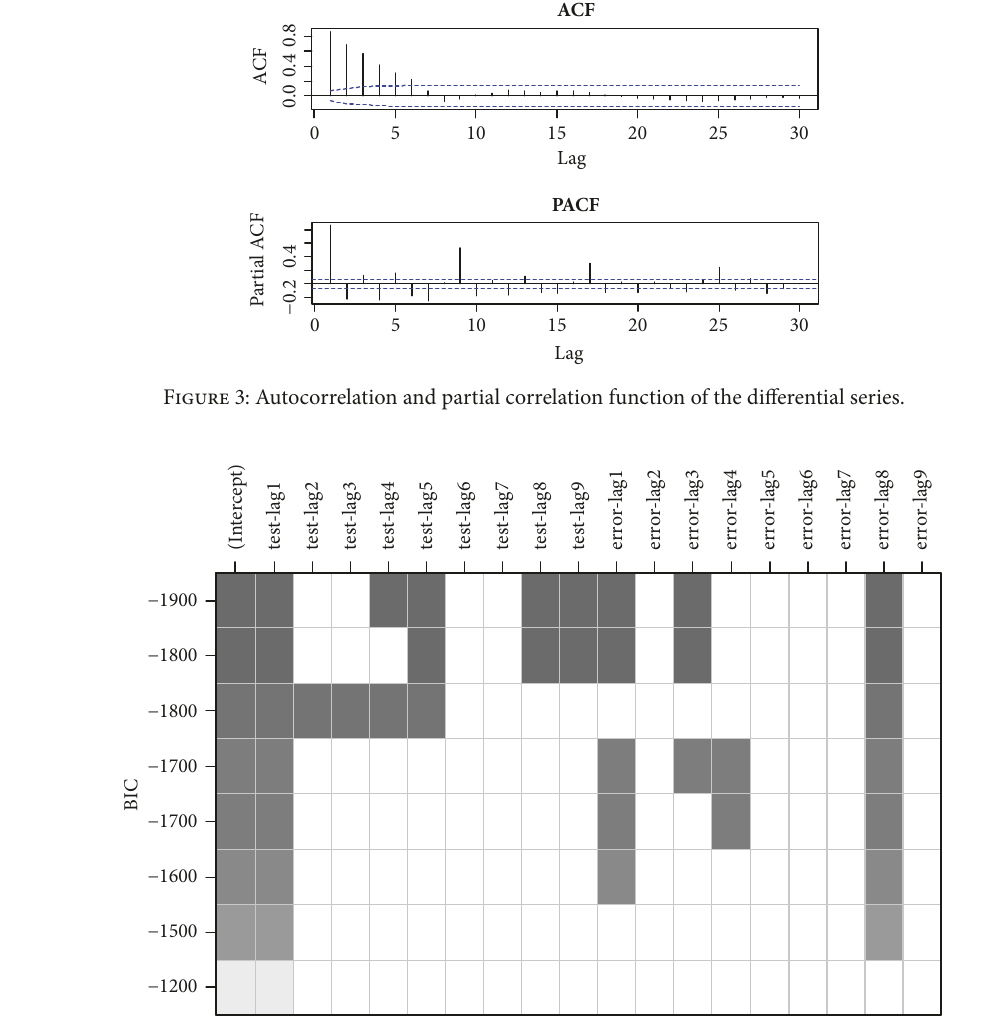
Figure 4: The BIC of the ARIMA